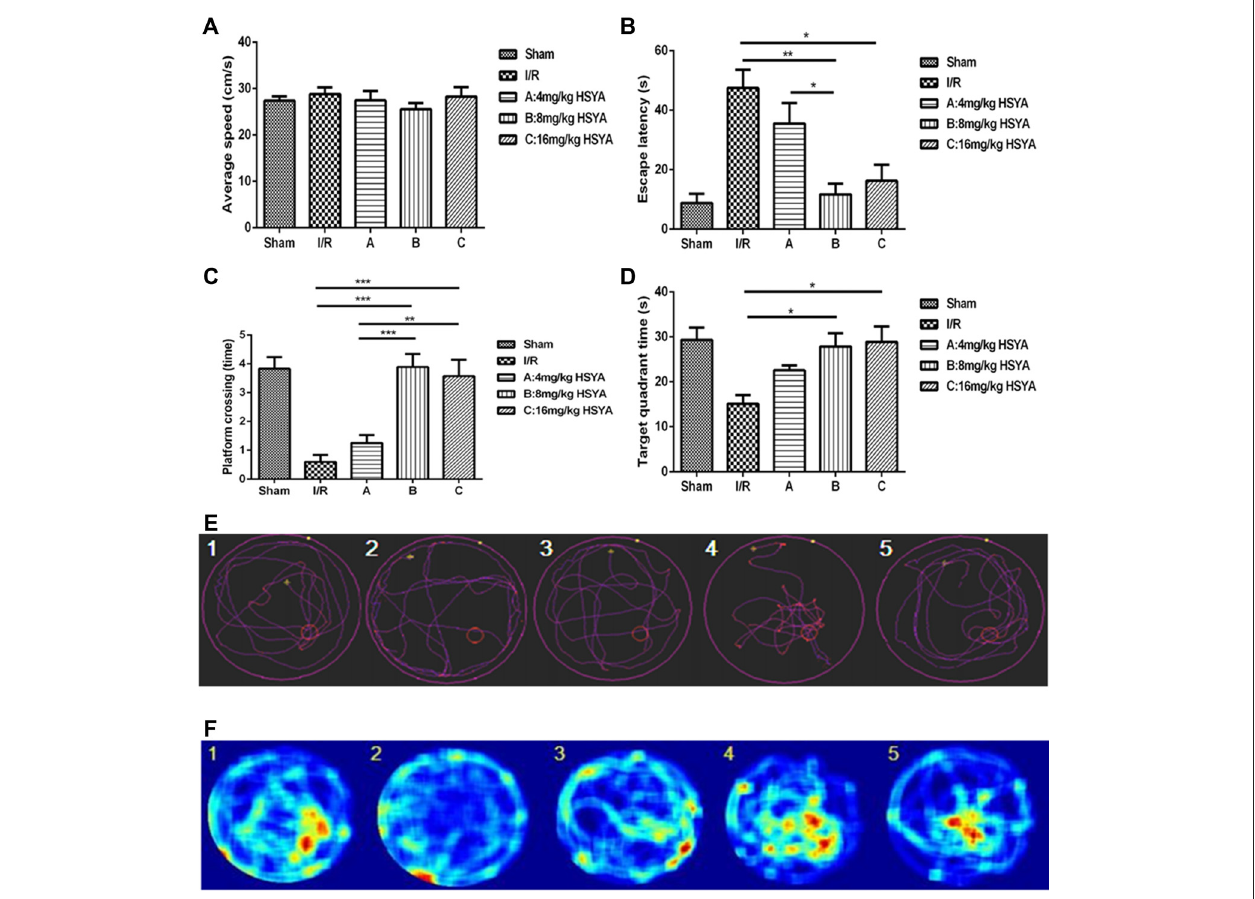
FIGURE 3 | Neuroprotective effects of HSYA on Morris water maze (MWM) test. (A) Average swimming speed, (B) escape latency, (C) platform crossing, (D) target quadrant time, (E) trajectory of swimming, (F) heat-variable images recording rats’ stay in the target quadrant. The values are shown as means ± SEM. Significant difference between MCAO group vs. 8 mg/kg HSYA ( ∗ P < 0.05) and 16 mg/kg HSYA groups ( ∗∗ P < 0.01), 4 mg/kg HSYA group vs. 8 mg/kg HSYA group ( ∗ P < 0.05) in escape latency; MCAO group vs. 8 mg/kg HSYA ( ∗∗∗ P < 0.001) and 16 mg/kg HSYA groups ( ∗∗∗ P < 0.001), 4 mg/kg HSYA vs. 8 mg/kg HSYA ( ∗∗∗ P < 0.001) and 16 mg/kg HSYA groups ( ∗∗ P < 0.01) in platform crossing; MCAO group vs. 8 mg/kg HSYA ( ∗ P < 0.05) and 16 mg/kg HSYA groups ( ∗ P < 0.05) in target quadrant